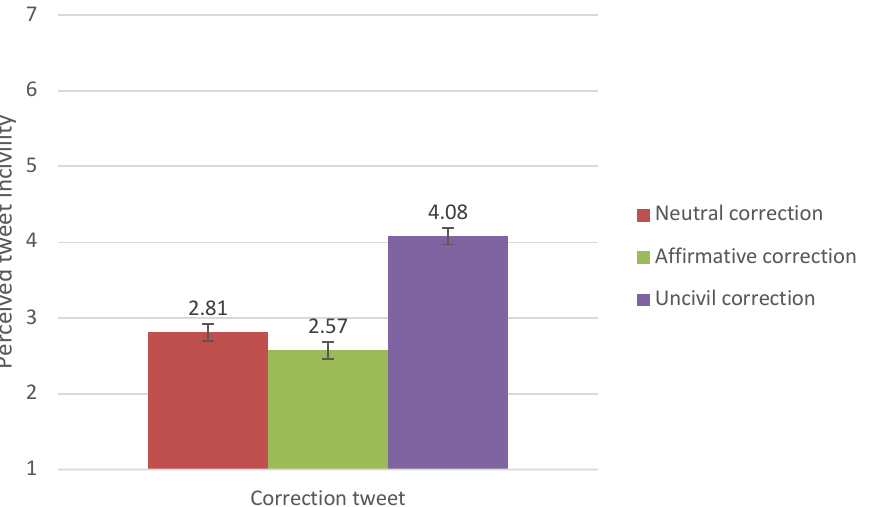
Figure 3. Perceptions of Correction Incivility by Experimental Condition. Note that higher numbers reflect greater perceptions of incivility. Each color shows the average for the group. Error bars represent a 95% confidence interval for the